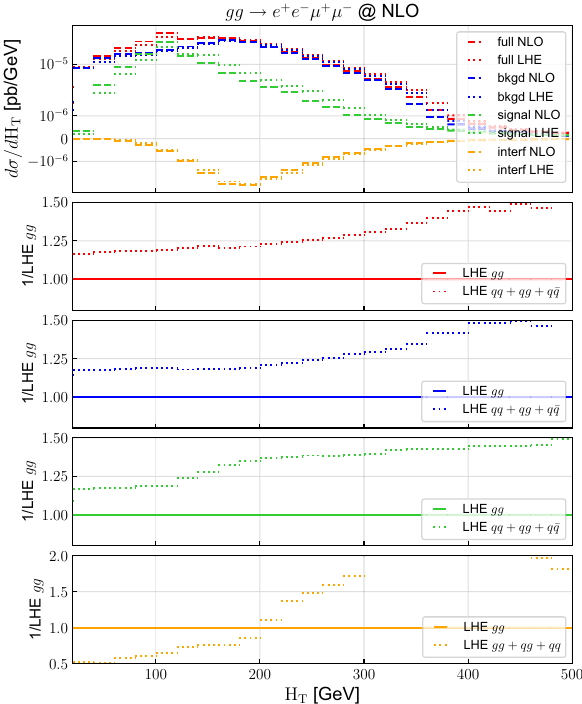
Fig. 13 Differential distribution in H T in gg → e + e − μ + μ − at NLO and LHE level. Predictions, colour coding and bands as in Fig.